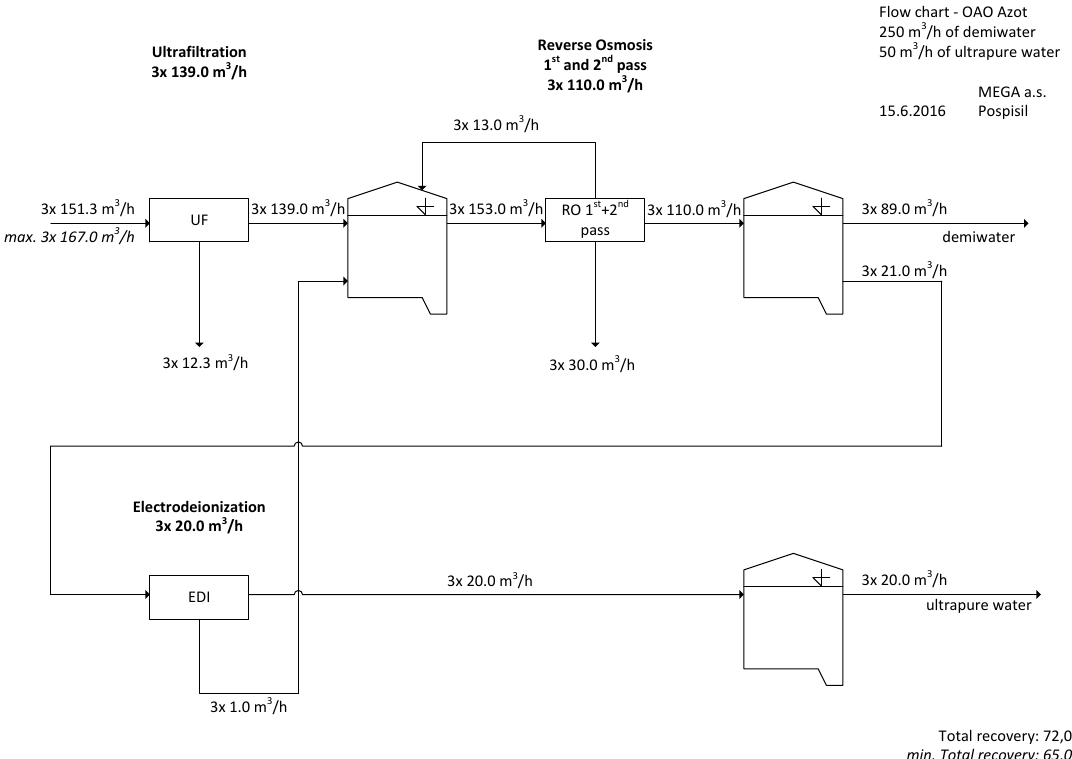
Figure 4. Example of industrial design of preparation of ultrapure make-up water for boilers using membrane technology, Mega Group (Czechia) [6,15–17]. The scheme shows water needs of membrane processes which is reflected to higher water cost compared to Ion Exchange technology. That is also the reason to recycle waste streams as much as possible as seen in this